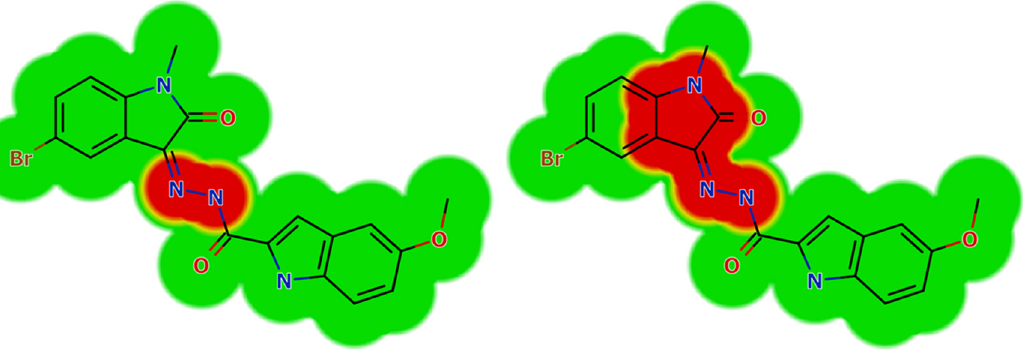
Figure 8: Structural alerts ( hydrazine and arylhydrazine ) for compounds 1 – 7 and metabolites of compound 1 giving rise to skin sensitization, chromosome damage and mutagenicity using DEREK software. ( Skin sensitization ( hydrazine moiety ) , chromosome damage and mutagenicity ( arylhydrazine moiety ) labeled with red color using the DEREK module of StarDrop software. )